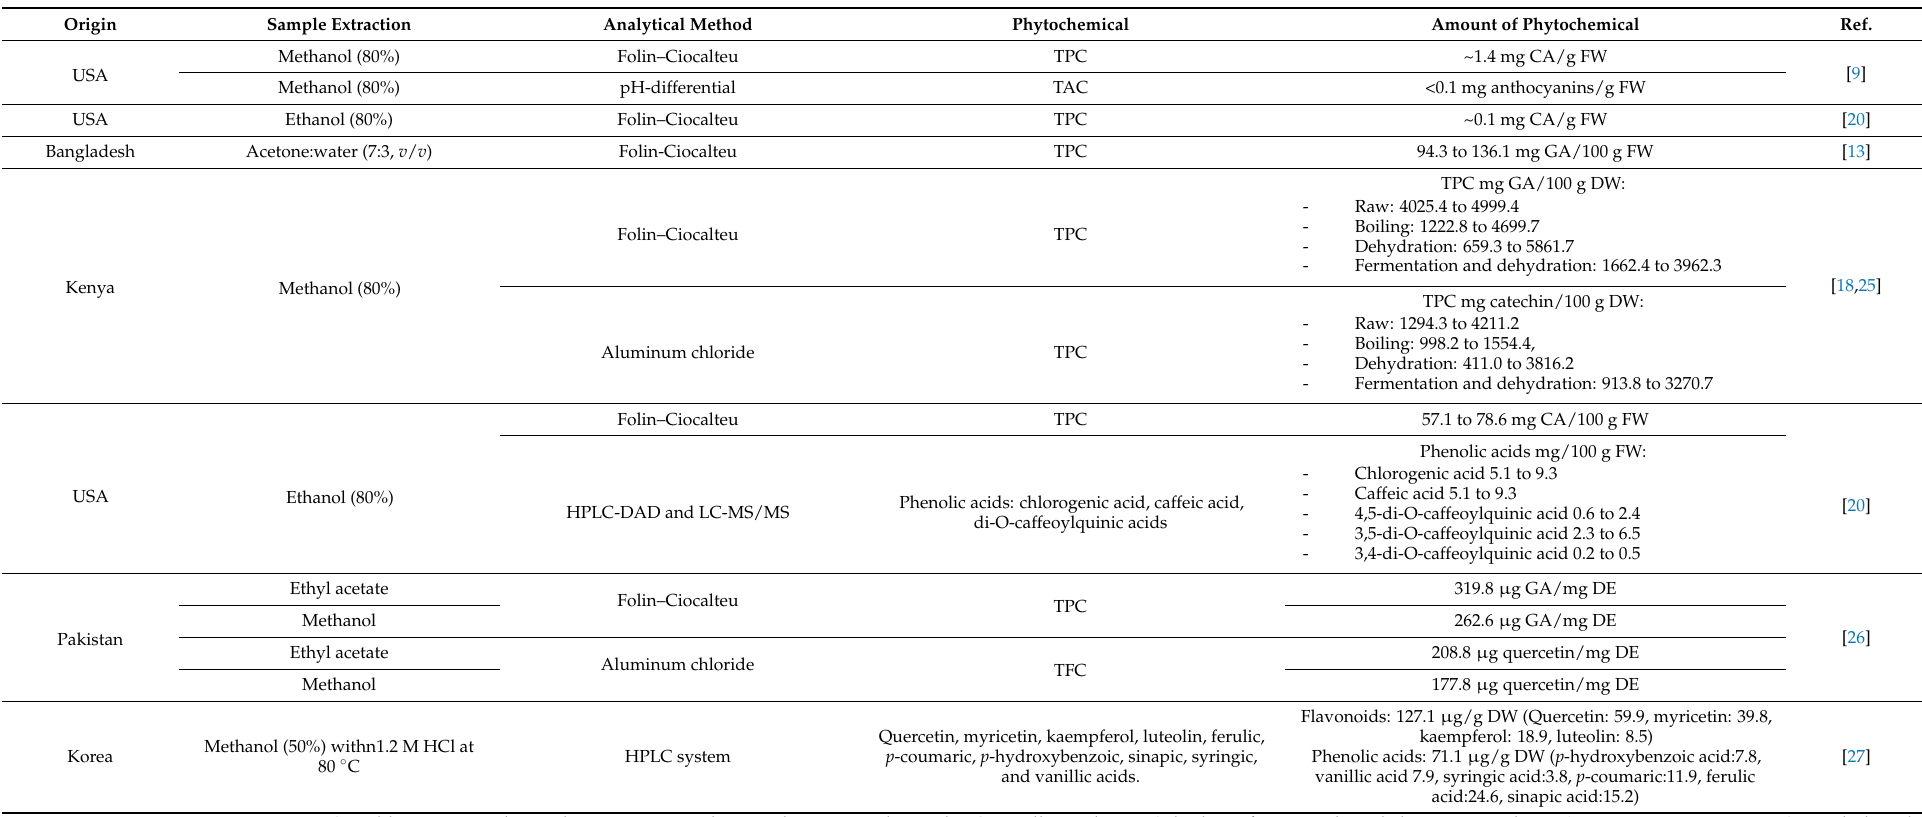
Table 1. (Poly)phenol content of orange sweet potato